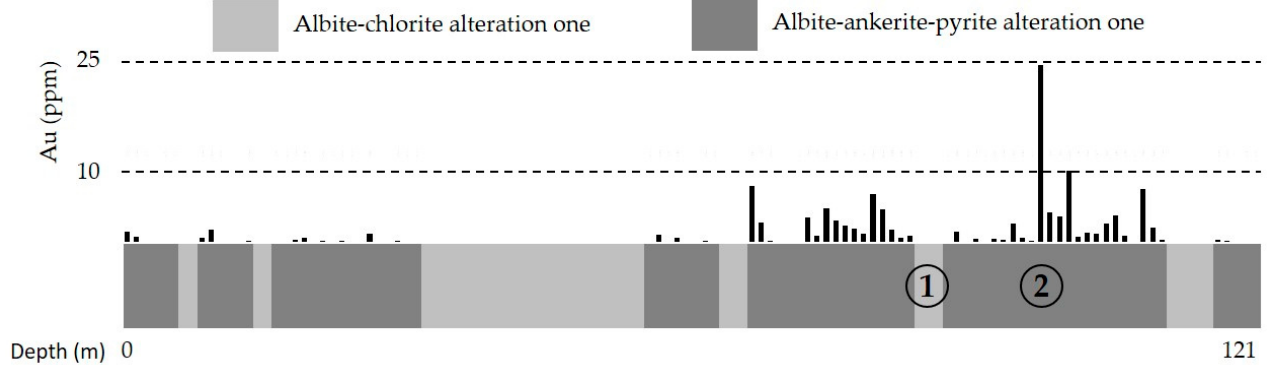
Figure 2. Sketch of core log of drill hole number 638 with the gold content [23]. 1 = sample of albite–chlorite alteration zone, 2 = sample of albite–ankerite–pyrite alteration zone.